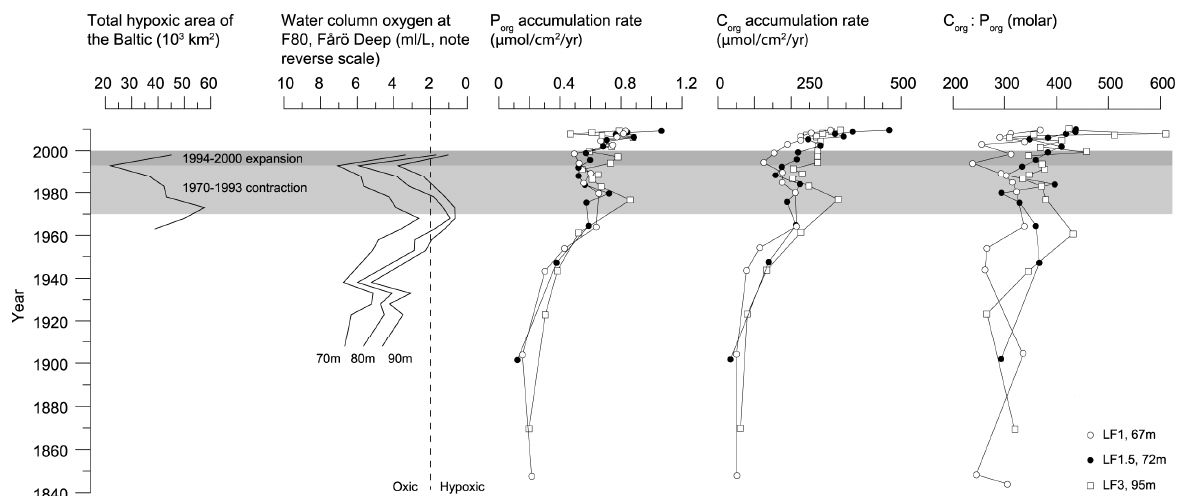
Fig. 7. Time series of C org and P org accumulation rates, and C org /P org , at sites LF1, LF1.5 and LF3 on the margins of the F ˚ ar ¨ o Deep in the central Baltic, and relevant water column oxygen data. C org and P org accumulation rates were calculated from 210 Pb-derived mass accumulation rates (estimated using a Constant Rate of 210 Pb Supply (CRS) model (Boer et al., 2006) and C org and P org contents). Total hypoxic area data from Conley et al. (2009) and water column oxygen concentrations at site F80 from the Baltic Sea Environmental Database at Stockholm University are plotted as 5 year binned mean values.